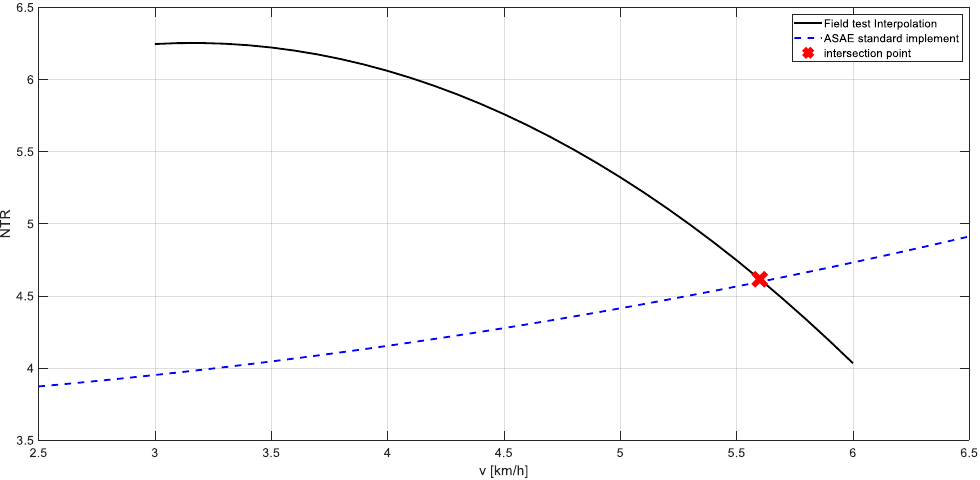
Figure 4. Example of the expected working condition of the tractor-plough system for TT in FE configuration and 8th gear. Table 5. Regression curve for NTR as a function of v (TT in 8th gear).